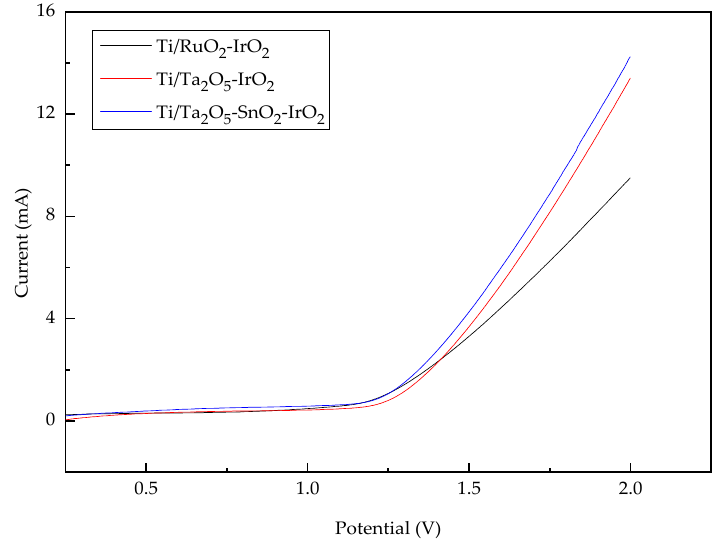
Figure 3. Linear sweep voltammetry (LSV) curves of three electrodes at scan rate of 50 mV/s.